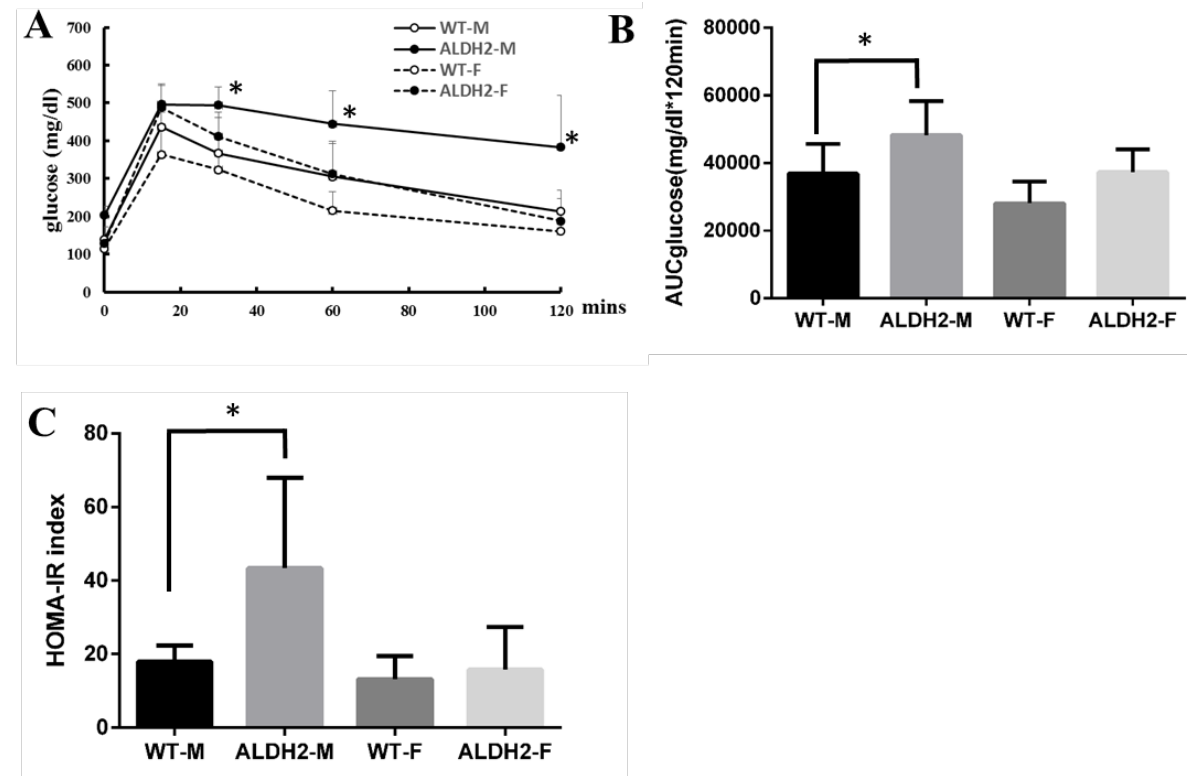
Figure 2. Oral glucose-tolerance test and HOMA-IR index. OGTT was performed at 6 h fasted ( n = 5 and 6). ( A ) Glycemic values before (basal) and 15, 30, 60, and 120 min after glucose loading; ( B ) area underneath the curve (AUC); ( C ) homeostatic-model assessment for insulin resistance (HOMA-IR). Results are presented as mean ± SD. * p < 0.05 vs. WT-M.